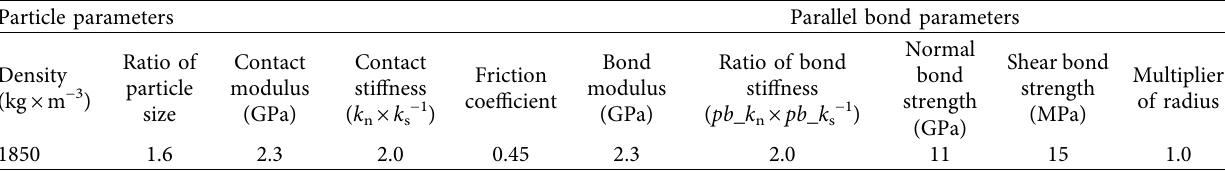
Table 1: Particles microscopic parameters of group A.